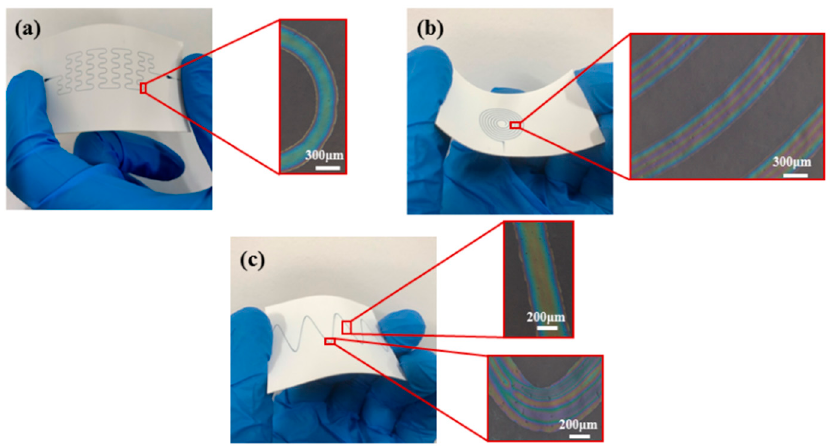
Figure 4. Fabricating organic micro patterns of various shapes on the flexible insulating substrate. ( a ) The organic micro pattern of the second-order self-similar structure curve. ( b ) The organic micro pattern of the helical curve. ( c ) The organic micro pattern of the wave curve.